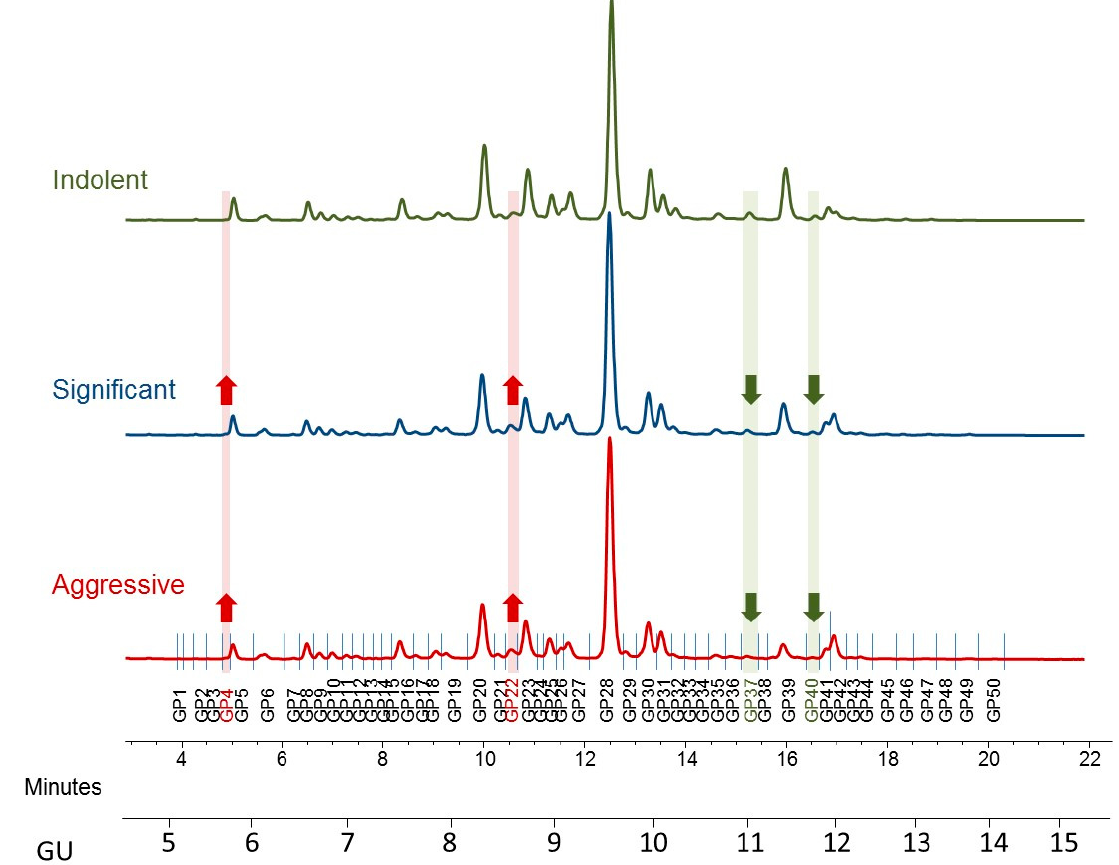
Figure 1. Typical hydrophilic interaction chromatography ultra-performance liquid chromatography (HILIC-UPLC) profile of undigested serum N -glycome from prostate cancer patients—representative profiles for indolent, significant, and aggressive disease. Highlighted are major differences: increased peaks with the disease progression are highlighted in red and decreased in green. Profiles are standardized against a dextran hydrolysate (GU, glucose unit). The HILIC-chromatogram, representing the total serum N -glycome from each patient, was separated into 50 peaks. Structural assignments are listed in Table 2.